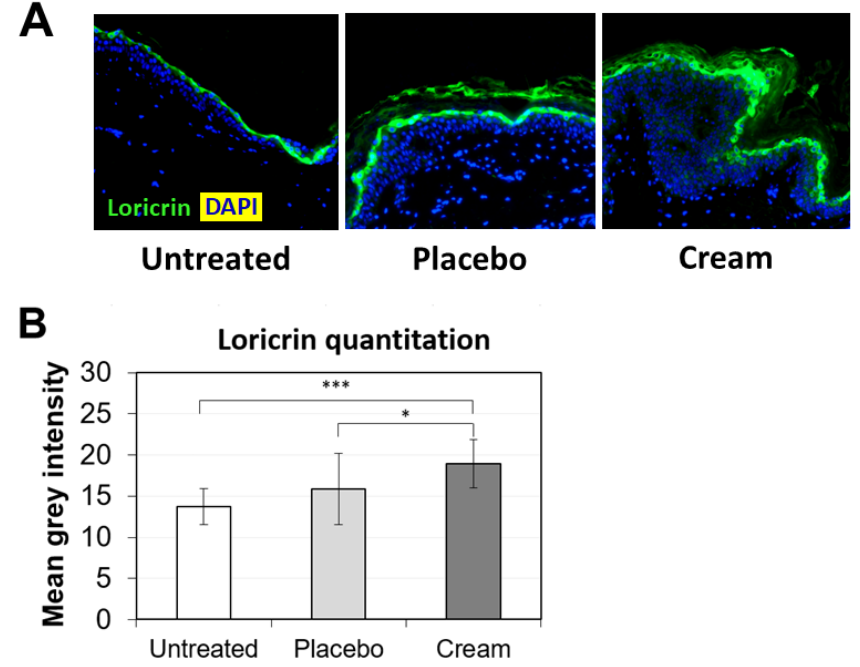
Figure 2. Assessment of loricrin in the epidermis by immunofluorescence on human skin explants after eight days of topical treatment. ( A ) Representative images of skin sections of the untreated, placebo (negative control formulation), and cream (test product) groups, where loricrin is visualized in green and the nucleus (DAPI) in blue (biological replicates n = 3). ( B ) Loricrin expression was quantitated by image processing and analysis of n = 5 images. Statistical comparison of the mean values was achieved using a t -test (*** p < 0.001 and * p < 0.05).